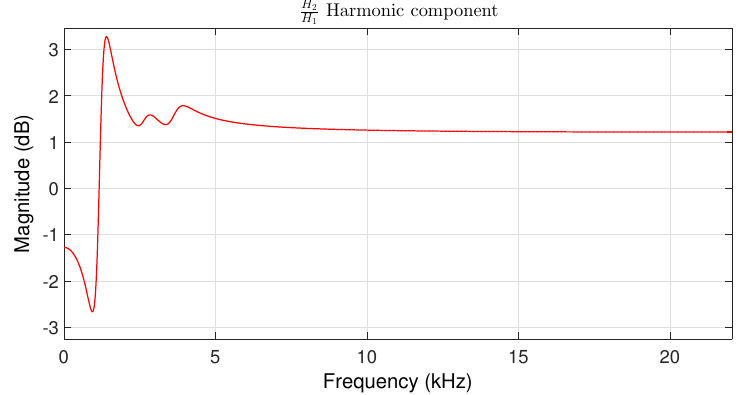
Figure 8. Magnitude of the H 2 filter response of the harmonic component of an F 3 note (172.6 Hz) of a H 1 male singer to be pitch shifted a fifth